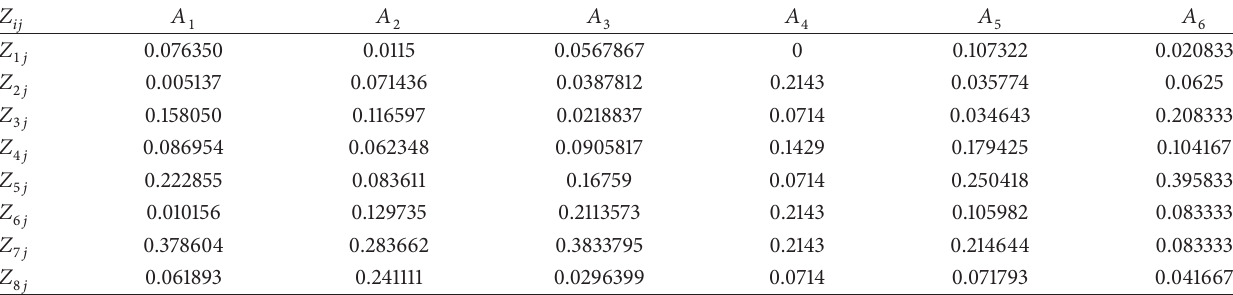
Table 5: Normalized nearness degrees of all index vectors with the fixed index